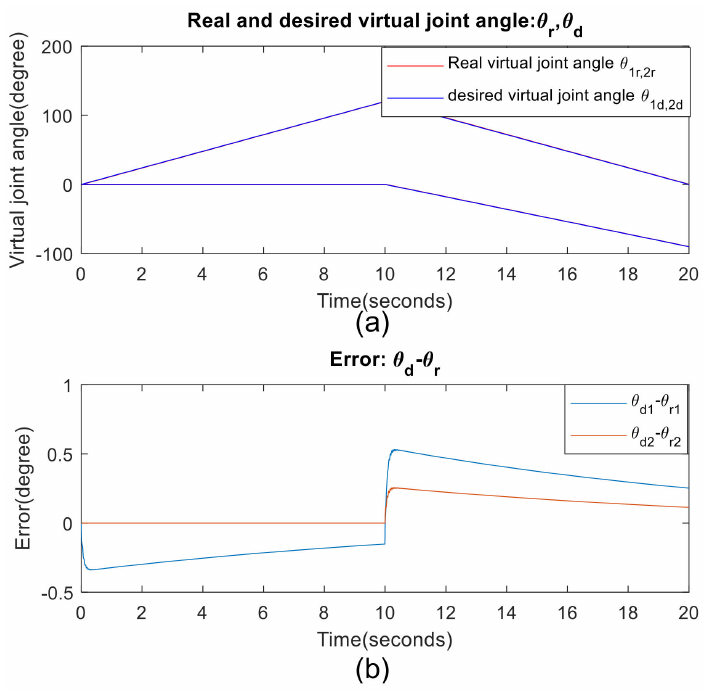
Figure 26. ( a ) Real and desired virtual joint angle; ( b ) error between real and desired virtual joint